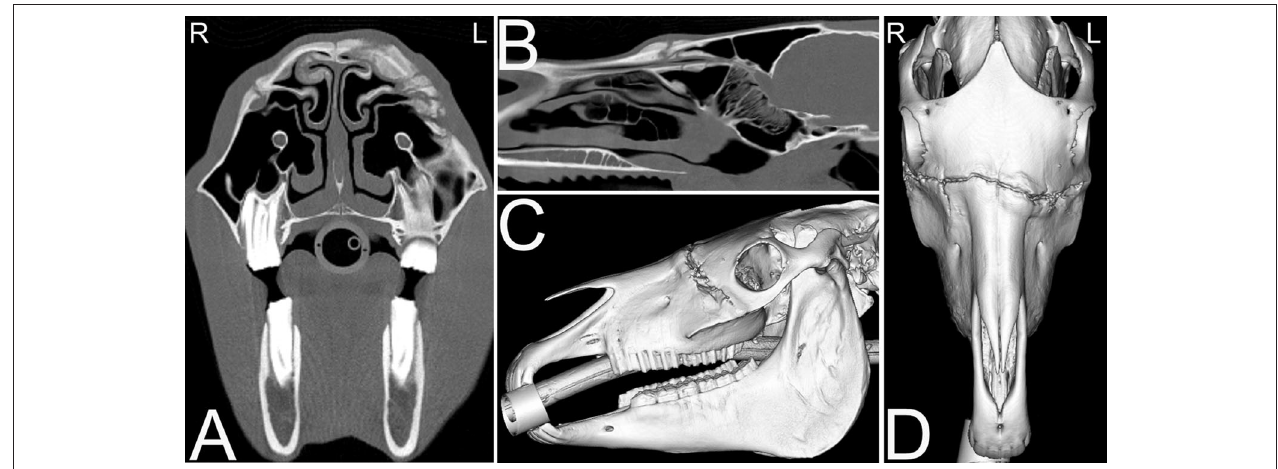
FIGURE 16 | Nasofrontal suture exostosis. Computed tomography images of the head of a 14-year-old Quarter horse mare presented for facial swelling of ∼ 1.5 months duration with possible history of facial trauma off a metal bar. On the transverse (A) and sagittal (B) CT images excessive osseous remodeling of skull at the level of the nasofrontal suture lines and other sites is noted. The remodeling is not exactly bilaterally symmetrical, and a traumatic cause is suspected. This remodeling is similarly noted on the sagittal (C) and dorsal (D) 3D CT images of the skull. Biopsy of the osseous remodeling of the suture revealed a pyogranulomatous periostitis. L, left; R,